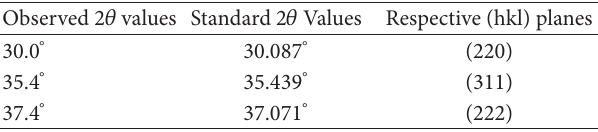
O micro/nanoparticles aer calcinations; (c) thermogravimetric analysis; particles. 3 4 3 4 T 2: Observed and standard 2 respective (hkl)